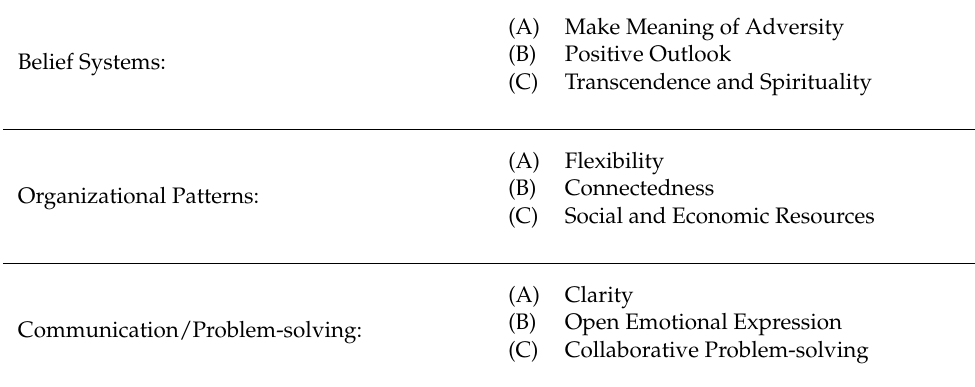
Table 1. Key processes in family resilience